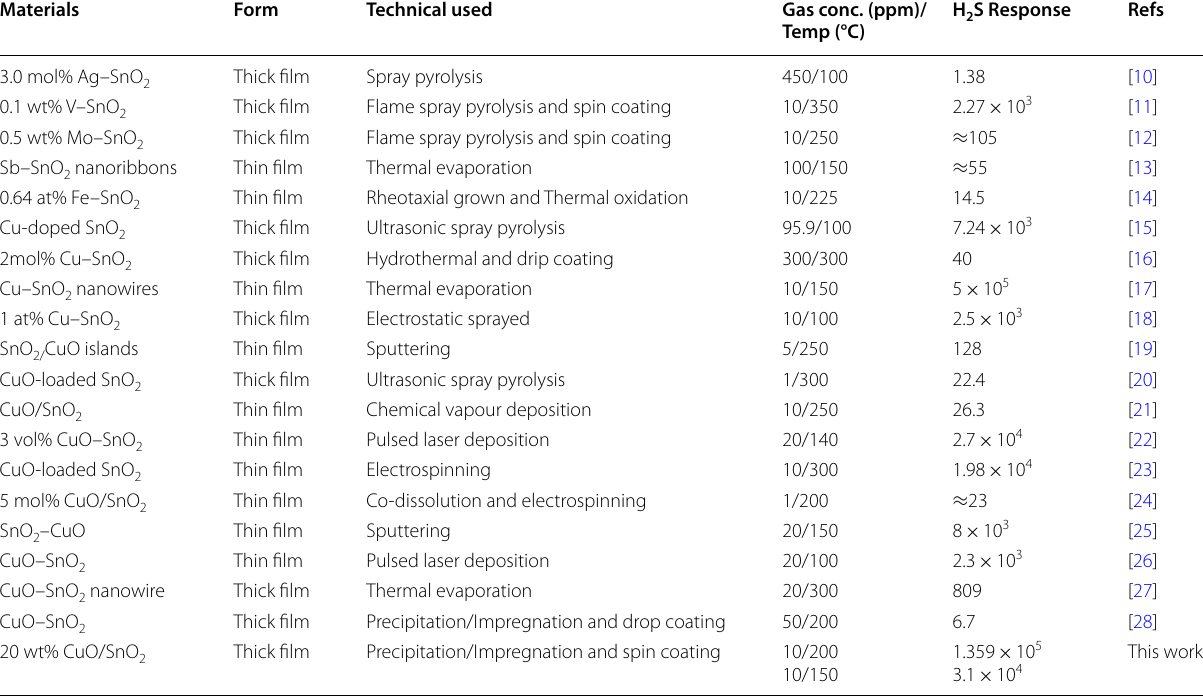
S response of metal-loaded SnO 2